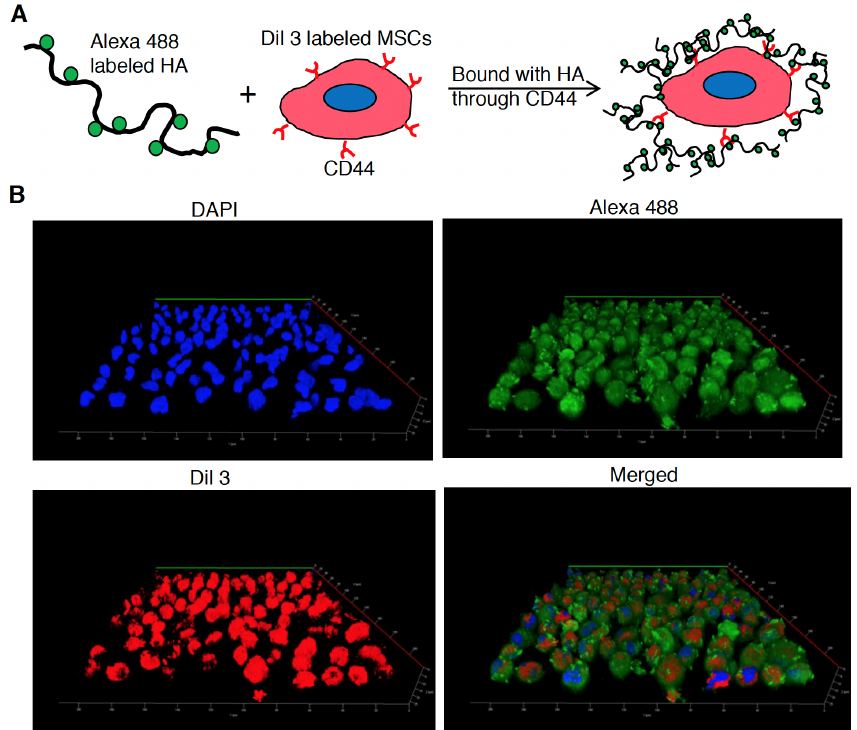
Figure 5. BV transduced BMSCs were encapsulated by hyaluronan for grafting in a punctured disc. ( A ) Scheme of Bac-Runx1, Bac-L-Runx1/Bac-Cre or mock transduced BMSCs bound with hyaluronan through CD44 receptor. For confocal microscope observation, hyaluronan was labeled with Alexa488, and BMSCs were marked with Dil3, respectively. BMSCs and hyaluronan were incubated at 37 °C, 30 min, followed by microscopic observation. ( B ) Representative images show the Bac-L-Runx1/Bac-Cre transduced BMSCs conjugated with hyaluronan and immediately observed in suspension status.